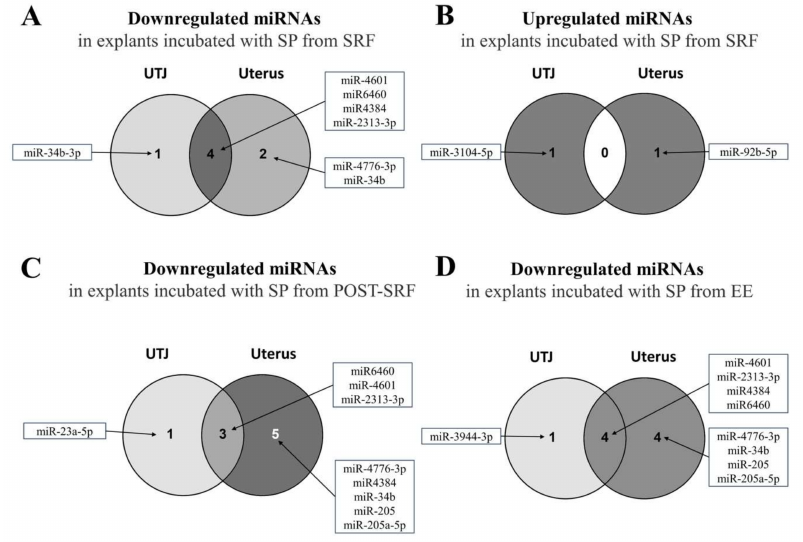
Figure 5. Venn diagrams showing the microRNAs (miRNAs) di ff erentially regulated (False Discovery Rate < 0.05 and ≥ 2.0-Fold Change or ≤− 2.0) in the media of mucosal explants and overlapped by each experimental treatment. The explants (uterus and utero-tubal junction (UTJ)) were cultured with medium 199 (M199) alone (Control) or supplemented with seminal plasma (SP) from di ff erent ejaculate fractions (sperm-rich fraction (SRF) and post-SRF) and from the recomposed ejaculate (EE). ( A ) MiRNAs downregulated in the media harvested from explants incubated with SP from SRF. ( B ) MiRNAs upregulated in the media from explants incubated with SP from SRF. ( C ) MiRNAs downregulated in the media from explants incubated with SP from post-SRF. ( D ) MiRNAs downregulated in the media from explants incubated with SP from